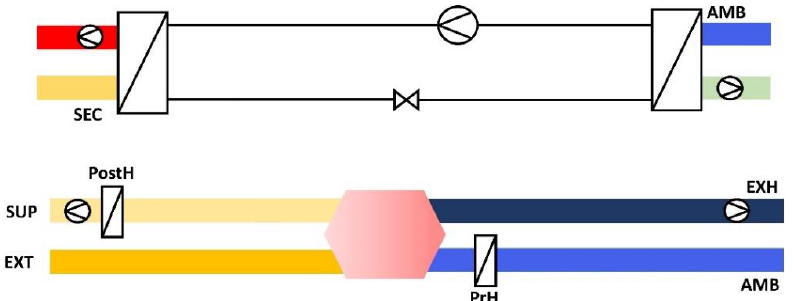
Figure 4. Scheme of air-to-air split-type heat pump with separate MVHR; additional room-wise electric radiators as post-heater are required in this concept (not depicted).